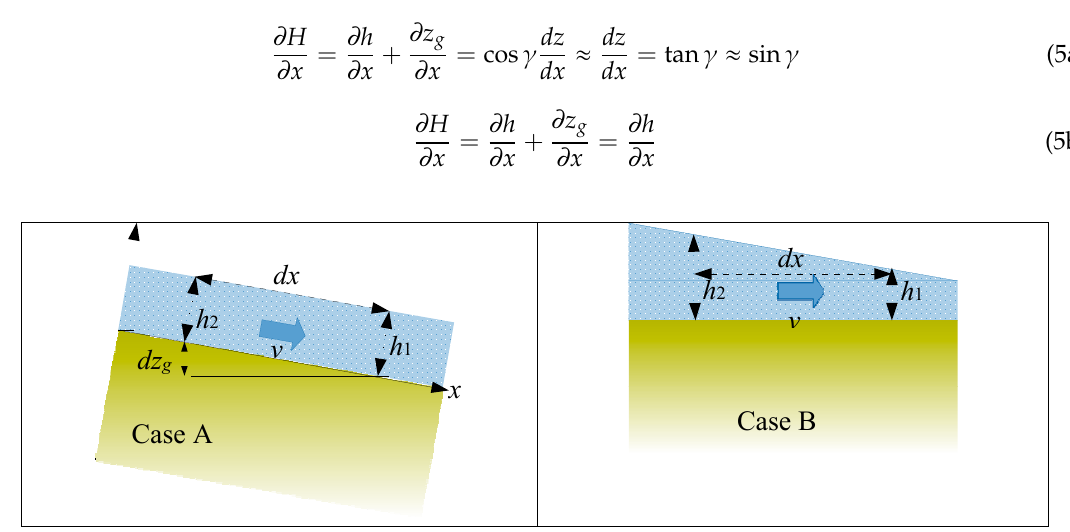
Figure 2. Case A is gravity gradient surface flow, and Case B is pressure gradient surface flow.